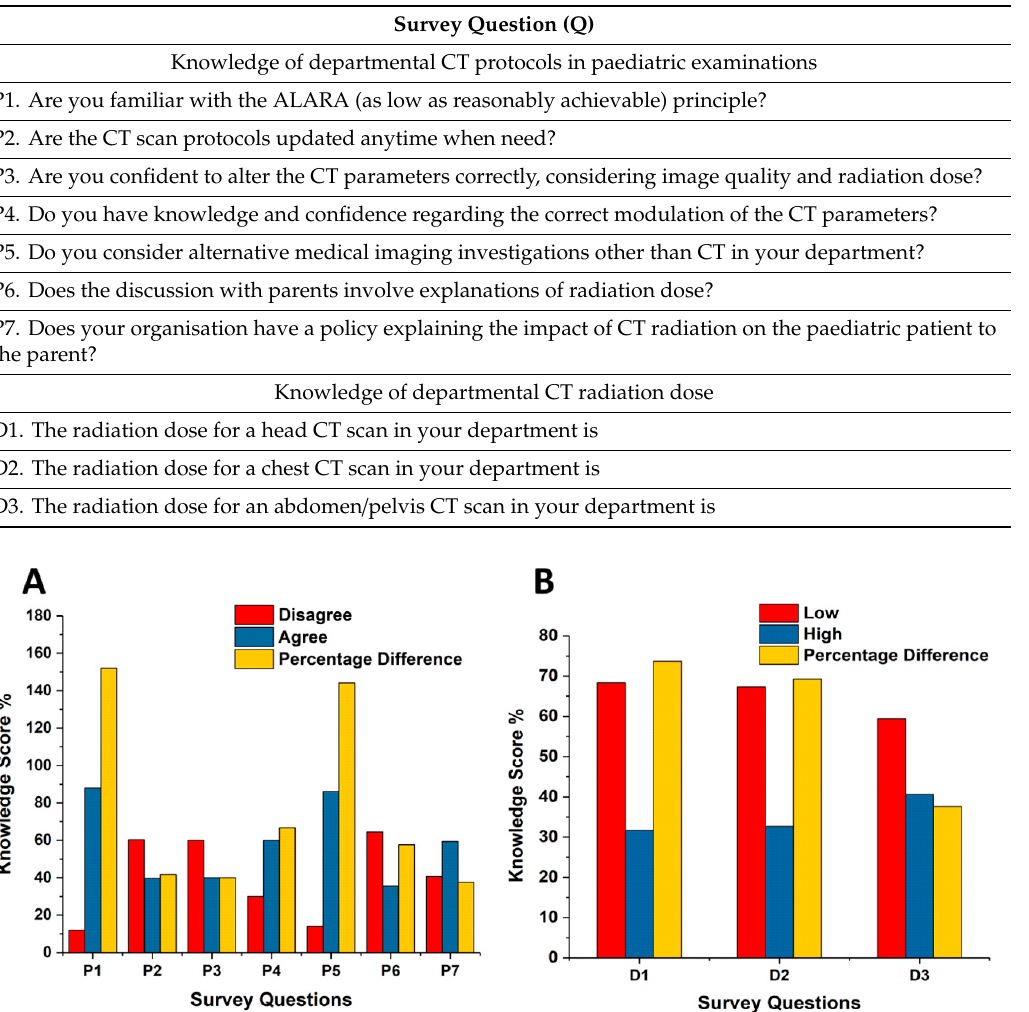
Figure2. Evaluationofparticipant’sknowledgeofdepartmentalCTprotocolsinpaediatricexaminations Figure 2. Evaluation of participant’s knowledge of departmental CT protocols in paediatric ( A ) and departmental CT radiation dose estimation ( B examinations ( A ) and departmental CT radiation dose estimation ( B ).